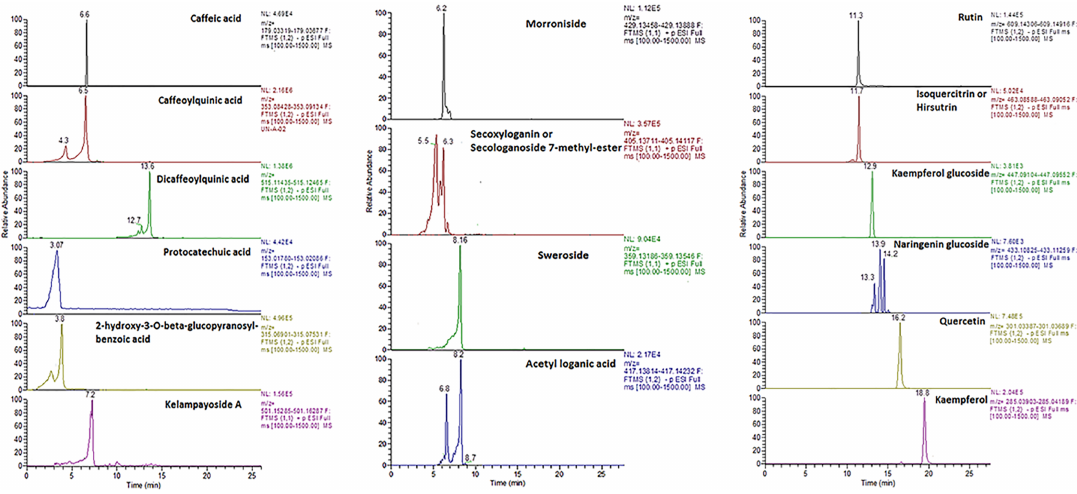
Fig 2. Extracted ion chromatograms of a: phenolic acids and kelampayoside A (phenolic apioglucoside), b: IGs and c: flavonoids in a representative extract of Strychnos cocculoides juice.